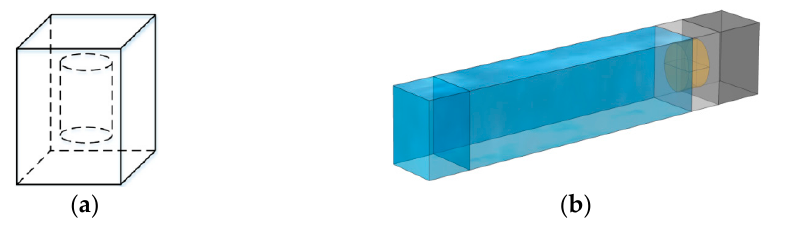
Figure 5. ( a ) Models in the literature, Reprinted with permission from Ref. [30] 2019, Zhong, J.; ( b ) The simulation model in the original manuscript.